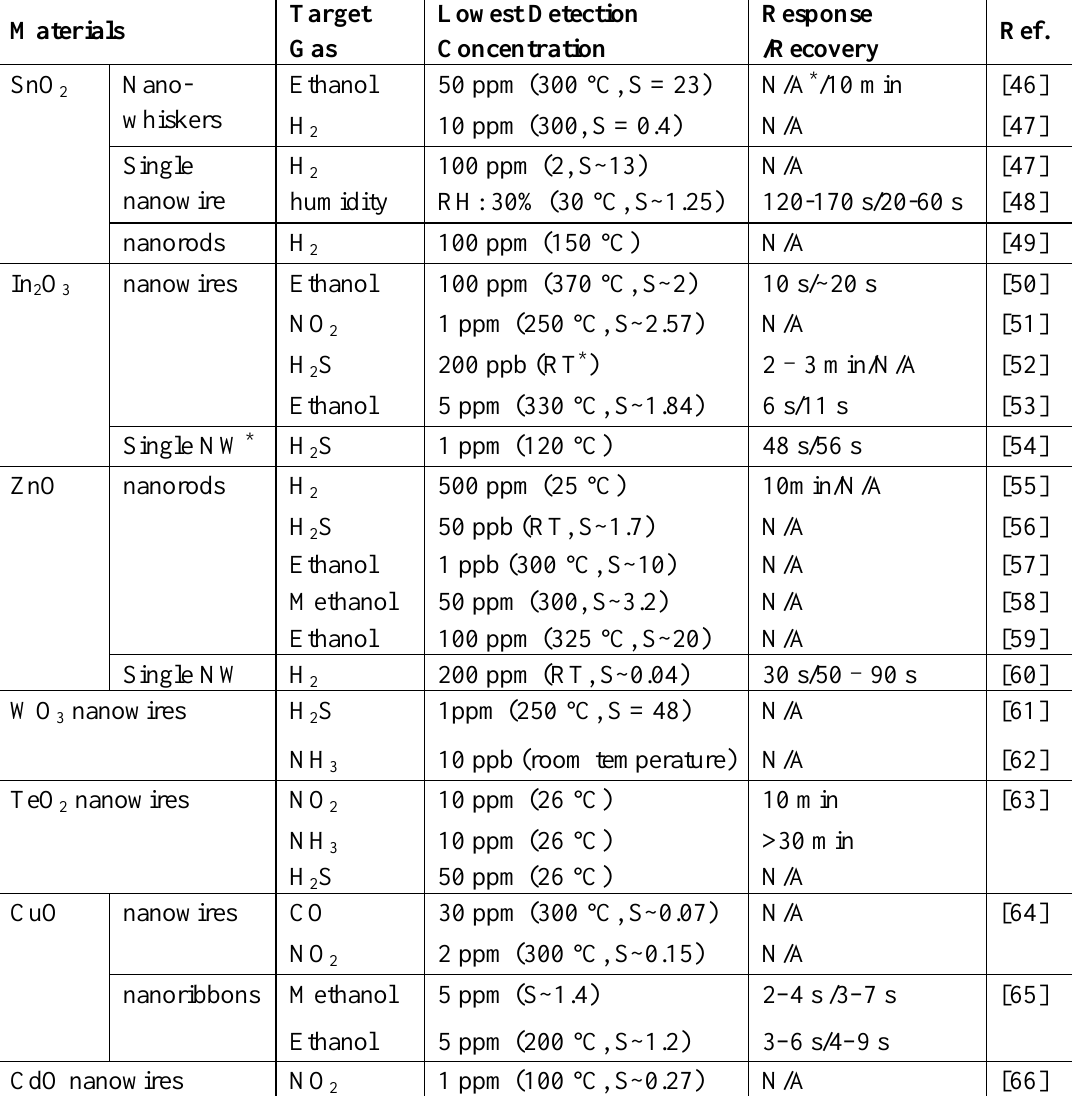
Table 1. Gas sensing properties of chemoresistors based on the one-dimensional nanostructures of different metal